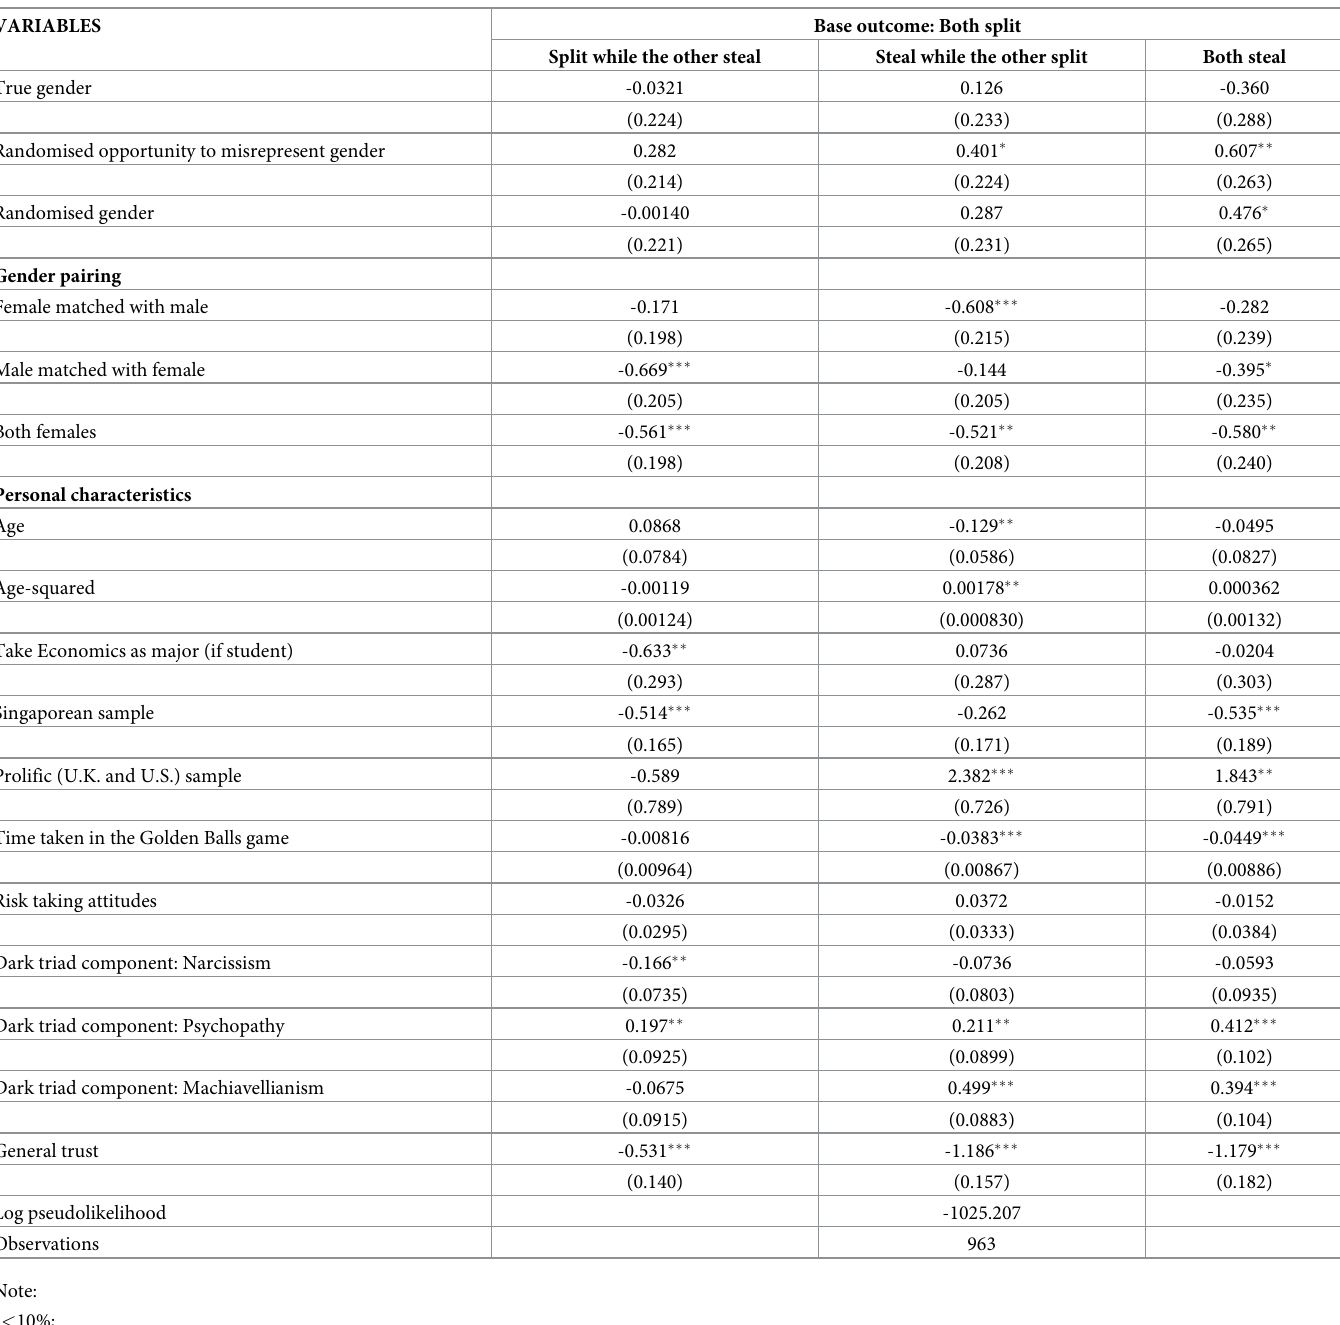
Table 3. The treatment effects on paired decision-making: Multinomial probit